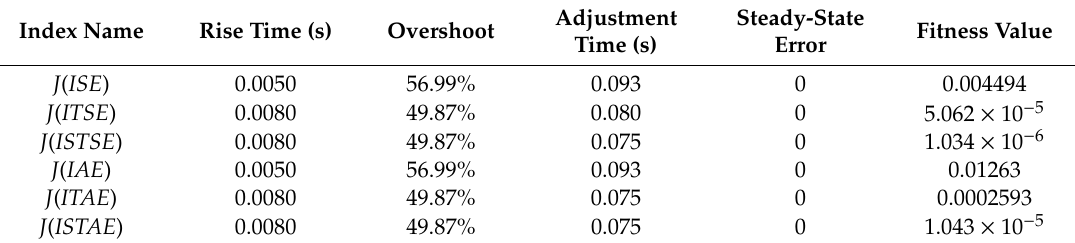
Table 1. Comparison of optimization